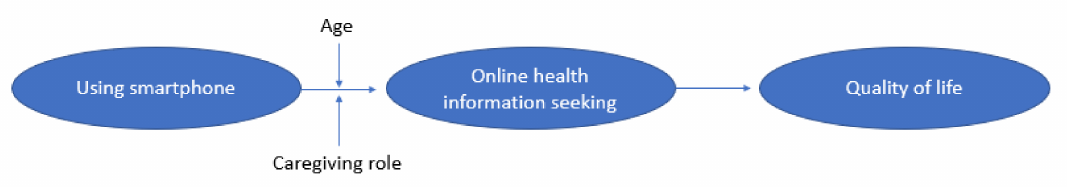
Figure 4. The partial research model of Ghahramani and Wang [11]. In this model, online health information seeking behavior was found to mediate the relationship between smartphone use and quality of life.